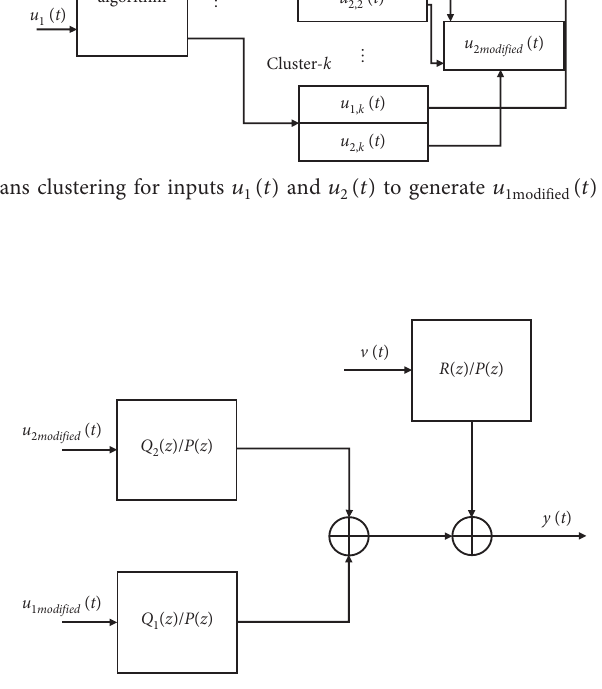
( t ) and u ( t ) 1modified 2modified